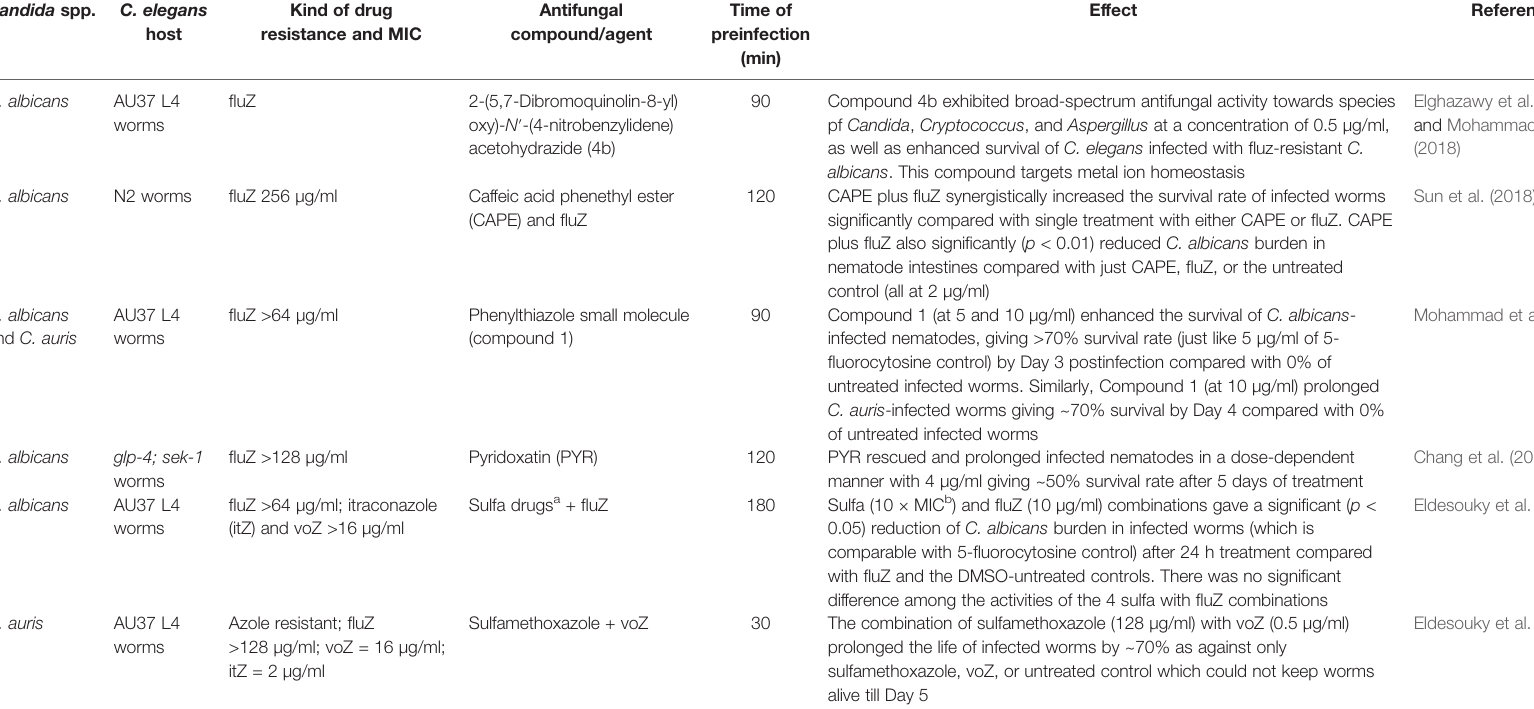
TABLE 3 | Evaluation of effective agents against drug-resistant Candida species in a C. elegans model. Candida spp. C. elegans